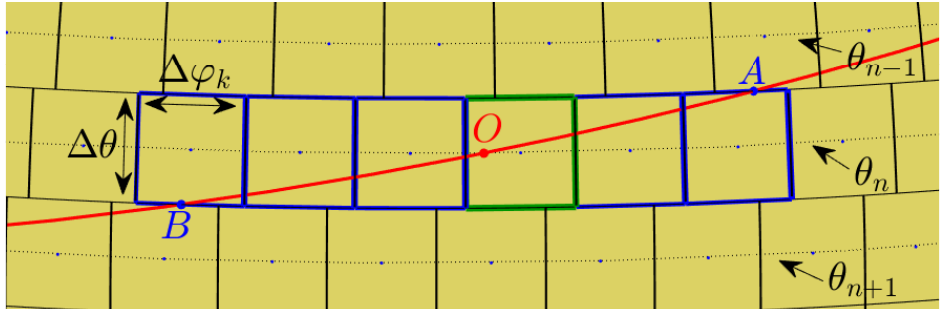
Figure 9. At layer θ n we increment the accumulator(s) between A and B inclusively. On the sphere, these points are the intersections of the primary circle with the upper and lower boundaries of the θ n layer. In the respective planar array, the points A and B are the intersections of the voting curve corresponding to the primary circle with the θ n layer. Had the approximation been employed, only the green cell would have been incremented, as its center is the closest (in terms of ϕ ) to the intersection of the curve with the sampled value of θ